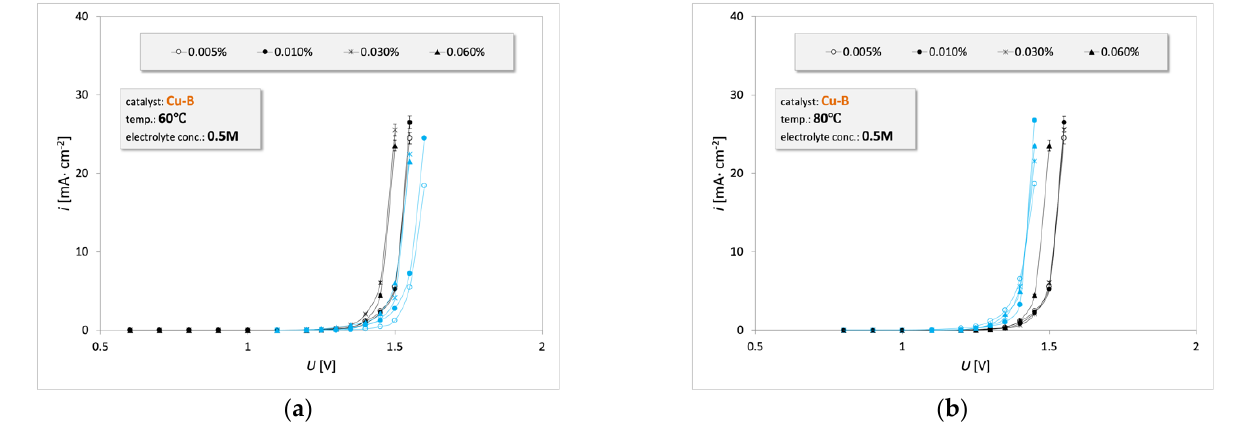
Figure 11. Electrooxidation curves of WEO emulsion (black lines) and detergent (blue lines) for various concentrations of detergent and emulsion on the Cu-B catalyst for an electrolyte concentration of 0.5 M. Electrooxidation: ( a ) temperature: 60 °C; ( b ) temperature: 80 °C.